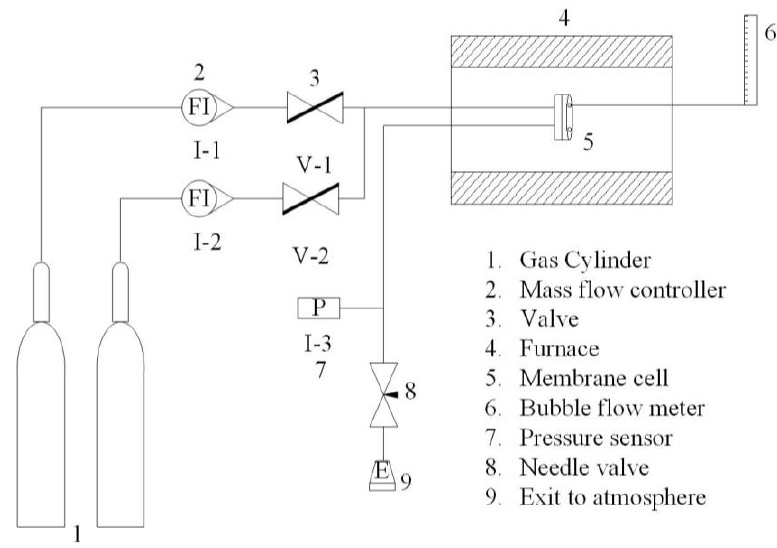
Figure 6. The steady-state permeation setup is depicted schematically.